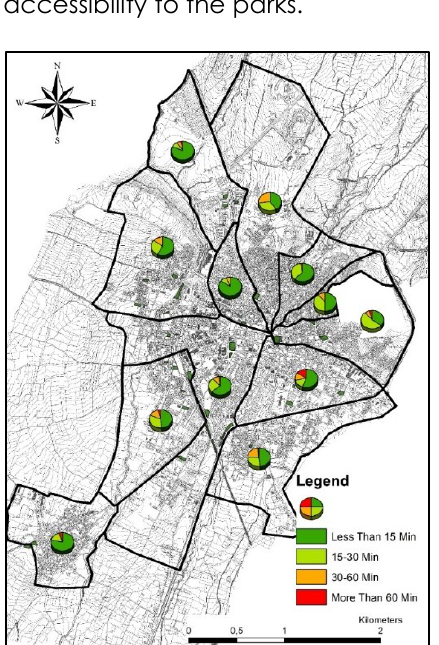
Figure 10. Duration of Urban Green Space